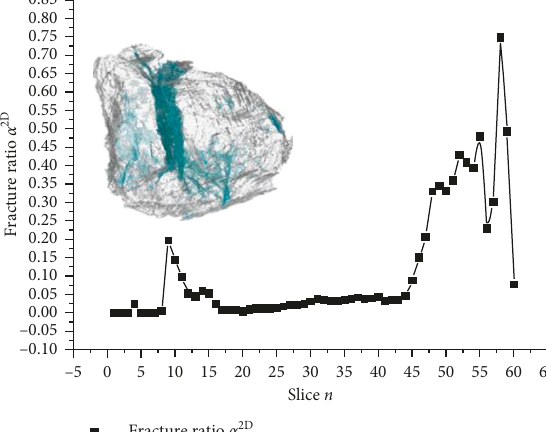
Figure 12: Variation tendency of fracture ratio in different slices of individual coal particles (the cracks are in blue and the coal gangue in grey).